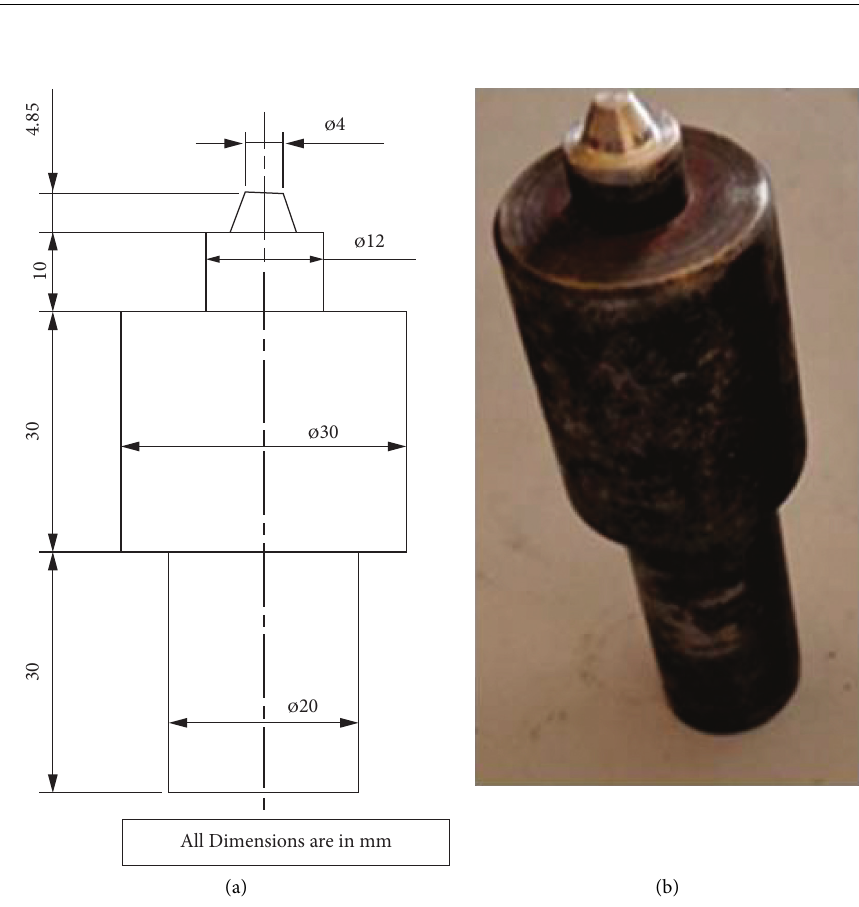
Figure 1: Geometry and photographic view of the FSW